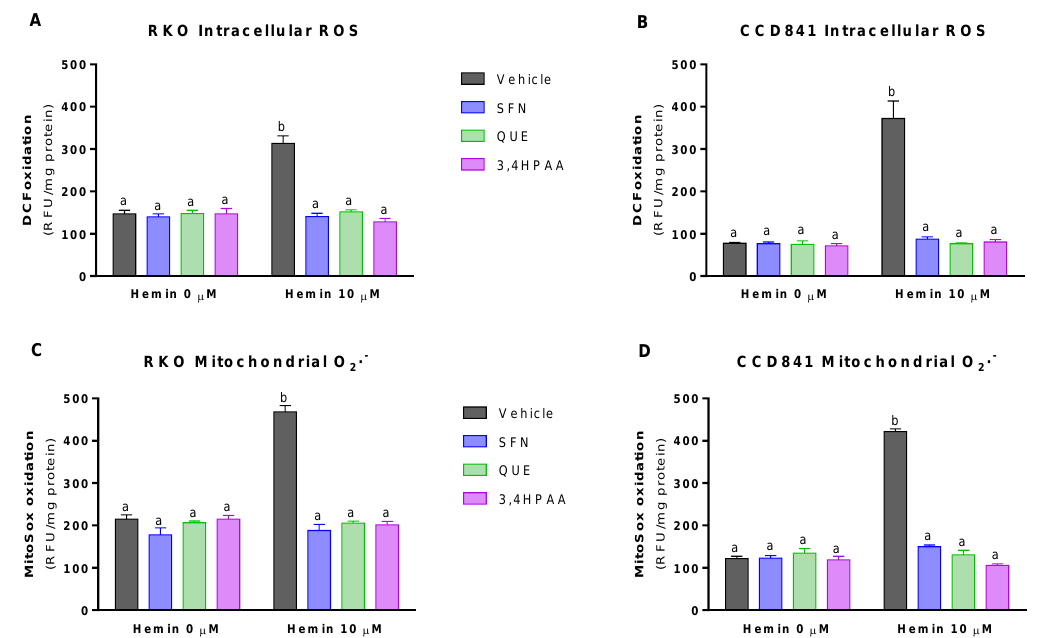
Figure 3. Effect of hemin, SFN, QUE and 3,4HPAA in ROS levels. Cells were incubated with vehicle (0.4% DMSO), 1 μM SFN, 10 μM QUE or 2.6 μM 3,4HPAA in the absence or presence of 10 μM hemin. After 72 h, DCF oxidation was measured by fluorescence in ( A ) RKO cells; and ( B ) CCD841 cells; as well as MitoSoxTM Red oxidation in ( C ) RKO cells; and ( D ) CCD841 cells. The results were expressed as RFU/mg of protein. Values are expressed as mean ± SEM, from three independent culture preparations. For all bars with the same letter, the difference between the means is not statistically significant. Values with different letters indicate significant differences ( p < 0.05) between bars (two-way ANOVA, Bonferroni post-test). 3,4HPAA, 3,4-dihydroxyphenylacetic acid; DCF, dichlorofluorescein; QUE, quercetin; SFN, sulforaphane; RFU, relative fluorescence unit.